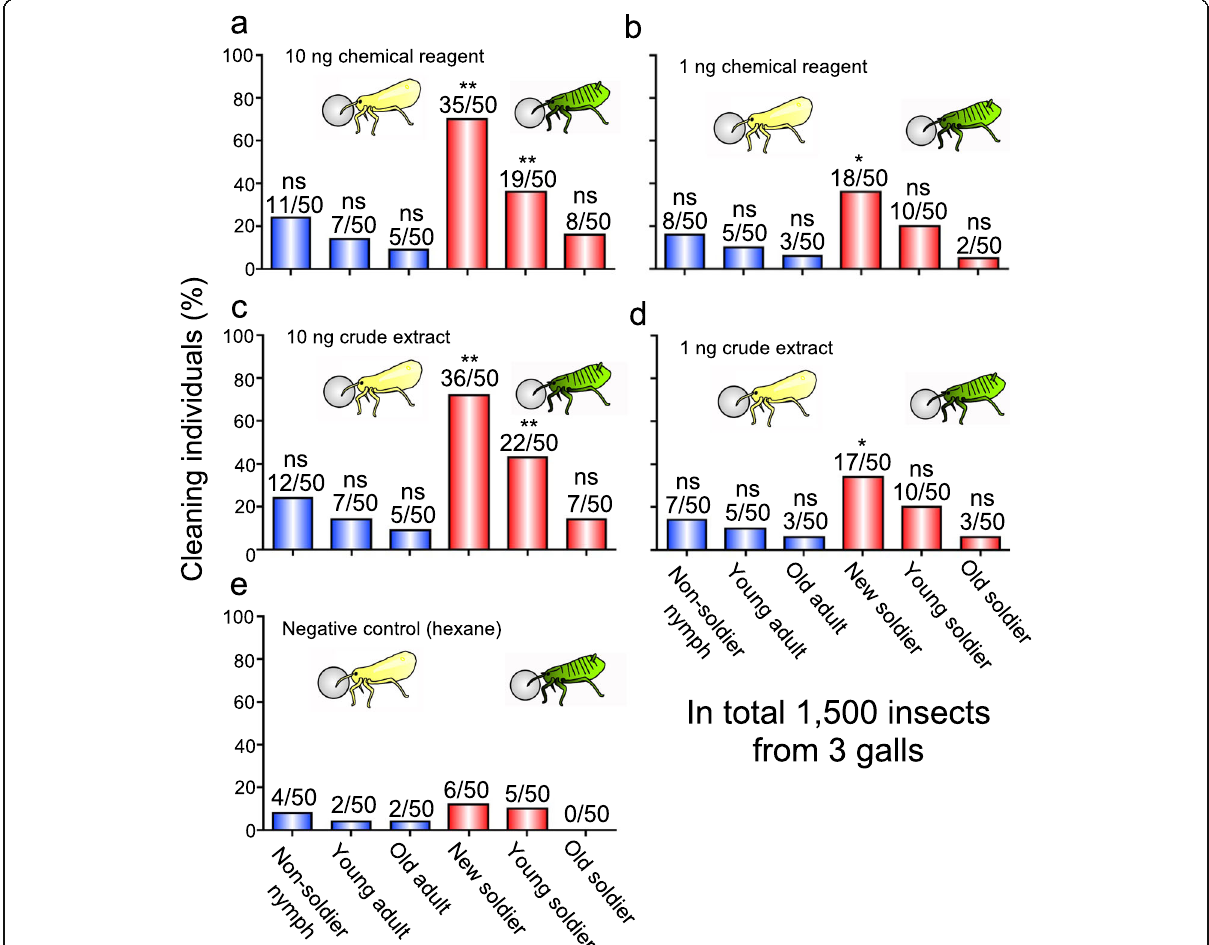
Fig. 6 Proportion of cleaning non-soldiers and soldiers of T. styraci against sample-coated glass beads. ( a ) Glass beads treated with 3000 ng linoleic acid per 20 μ l hexane. The test sample applied to individual glass beads is equivalent to 10 ng linoleic acid per bead. ( b ) Glass beads treated with 300 ng linoleic acid per 20 μ l hexane. The test sample applied to individual glass beads is equivalent to 1 ng linoleic acid per bead. ( c ) Glass beads treated with 1 x crude surface extract (500 dead old adults per 20 μ l hexane). The test sample applied to individual glass beads is equivalent to about 10 ng linoleic acid per bead. ( d ) Glass beads treated with 0.1 x crude surface extract (50 dead old adults per 20 μ l hexane). The test sample applied to individual glass beads is equivalent to about 1 ng linoleic acid per bead. Asterisks indicate statistically significant differences as compared with the counterpart control group (GLMM with sequential Bonferroni: *, P < 0.05; **, P < 0.01; ns, not significant). In total, 1500 insects from 3 galls, which contained non-soldier nymphs, unwinged adults, and second instar soldiers, were subjected to behavioral observations: non-soldier nymphs, second or third instar nymphs; young adults, adults within 7 days after final molt; old adults, adults of 8 days or older after final molt; new soldiers, soldiers within one day after molt; young soldiers, soldiers 10 days after molt; old soldiers, soldiers 20 days